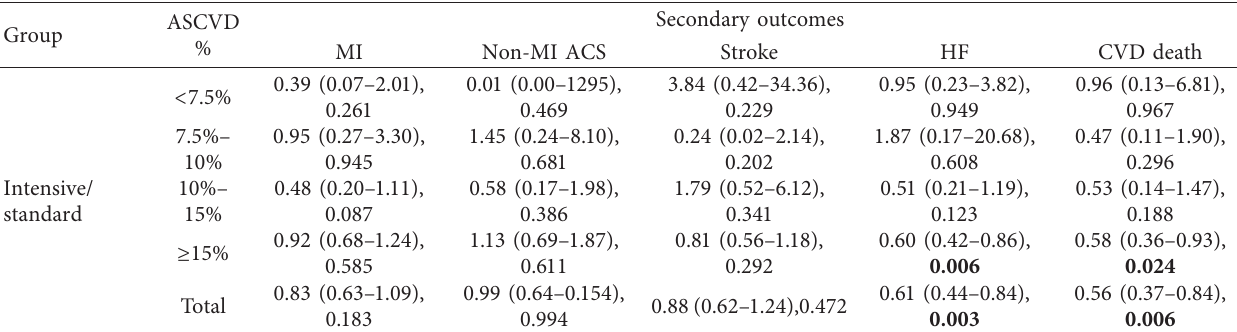
Figure 2: ASCVD-stratified Kaplan–Meier curve analysis was performed to compare the primary outcome between the intensive-treatment group and the standard-treatment group among the patients with ASCVD < 7.5%, 7.5% ≤ ASCVD < 10%, 10% ≤ ASCVD < 15%, and ASCVD ≥ 15%. (a) Hazard function for patterns 1-2 ASCVD groups: ASCVD < 7.5. (b) Hazard function for patterns 1-2 ASCVD groups: 7.5 ≤ ASCVD < 10. (c) Hazard function for patterns 1-2 ASCVD groups: 10 ≤ ASCVD < 15. (d) Hazard function for patterns 1-2 ASCVD groups: ASCVD ≥ 15. Table 3: Secondary outcomes in the intensive- and standard-treatment group.